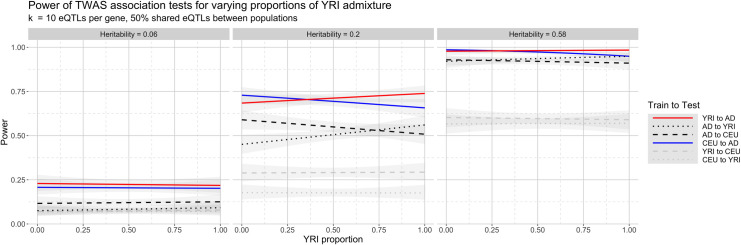
Power for various cross-population train-test scenarios with varying YRI admixture for three phenotypic heritability levels h2 = 0.06, 0.20, and 0.58, corresponding to effect sizes 0.005, 0.01, and 0.025, respectively.Power increases as heritability increases, but also as populations become more genetically similar. Raw power estimates and 95% confidence intervals are listed in S10–S12 Tables.